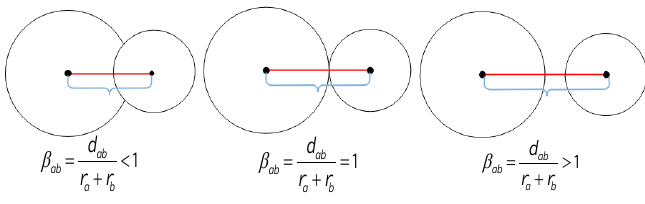
Figure 5. ( a ) Relationship between minimal sensitivity index and repulsive velocity. ( b ) The repulsive velocity produced at the center of the spherical volumes. Figure 4. The significance of the sensitivity index β Figure 4. The significance of the sensitivity index β.